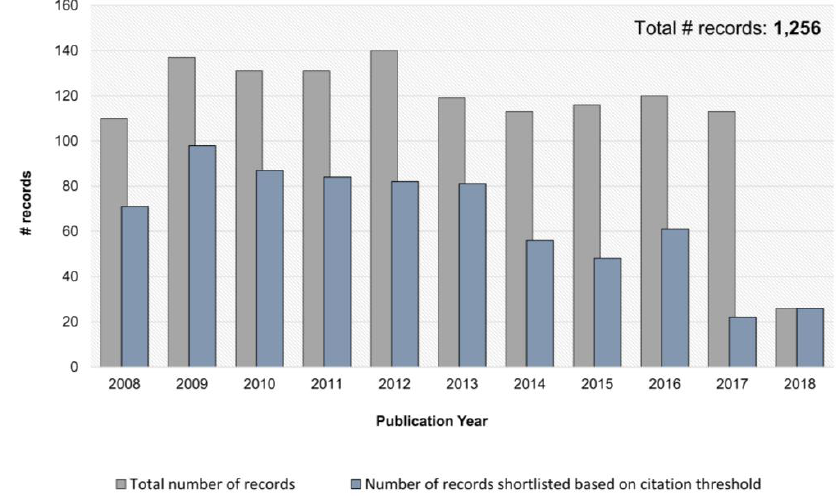
Figure 2. Overview of the number of articles published over last 10 years covering the TOPIC: (biomarker* or marker*) AND TOPIC: (proteome*) AND TOPIC: (“prostate cancer” or “prostate adeno*”), as retrieved using Web of Science.